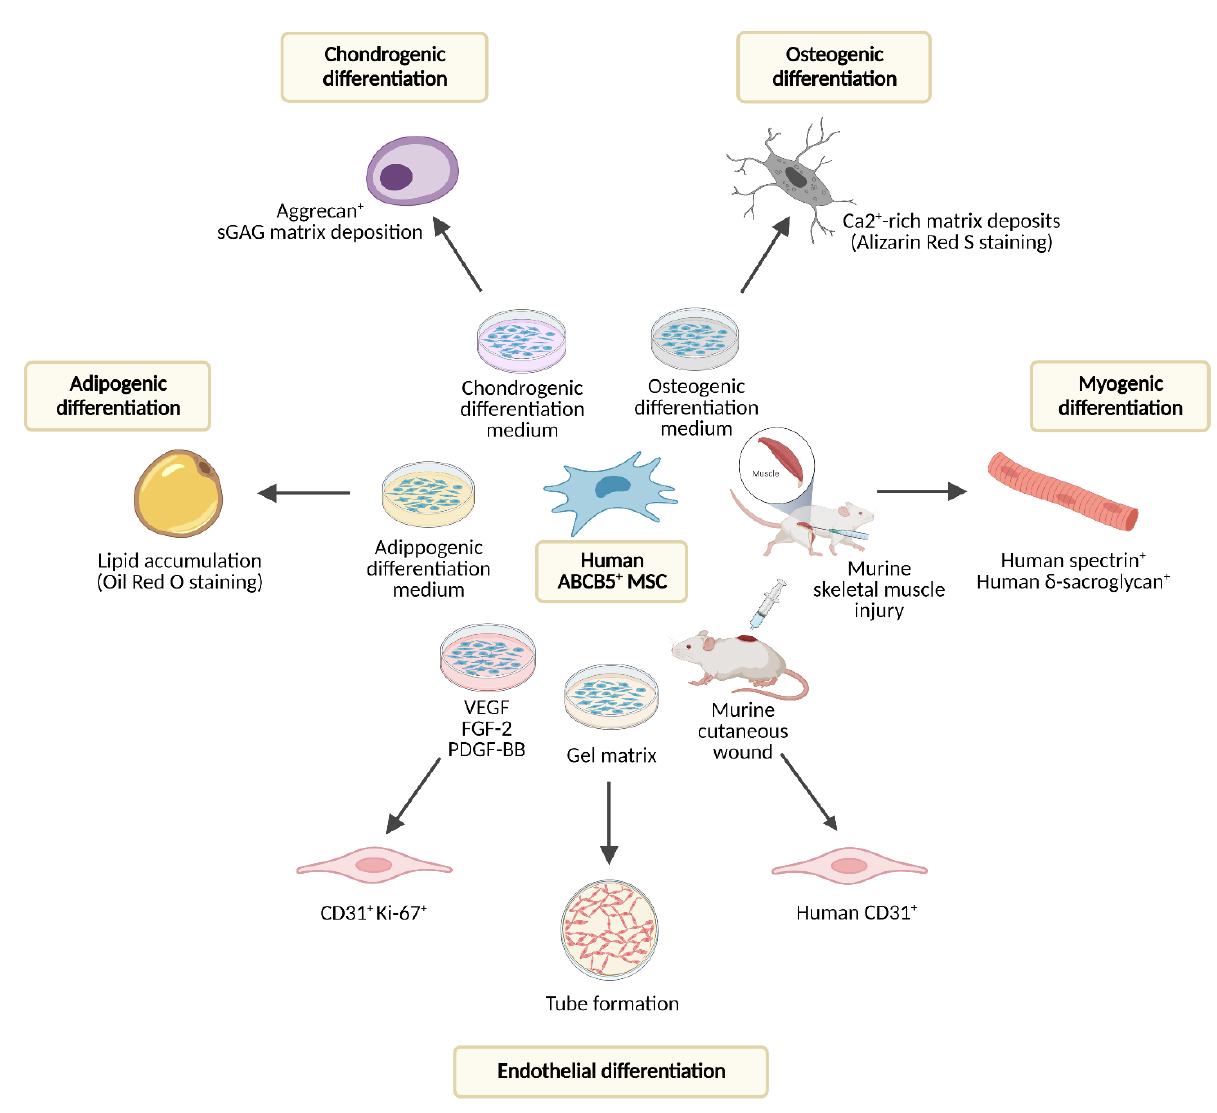
Figure 2. Differentiation potential of human dermal ABCB5 + MSCs studied in vitro and upon therapeutic application in mouse injury models. FGF-2 — fibroblast growth factor 2; PDGF-BB — platelet-derived growth factor BB; VEGF — vascular endothelial growth factor. Created with BioRender.com.